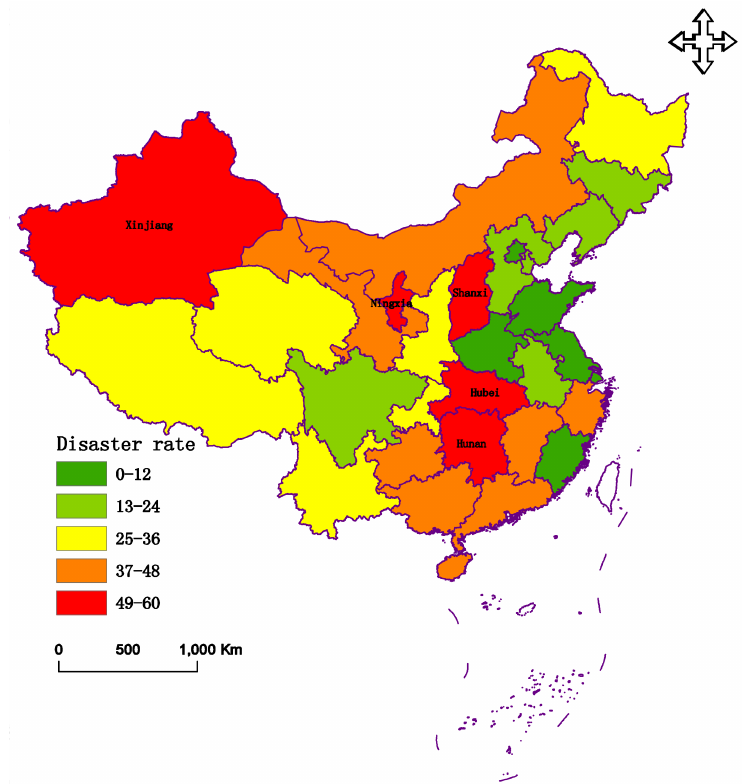
Figure 3. The data of disaster rate ( C 1) in 2008.